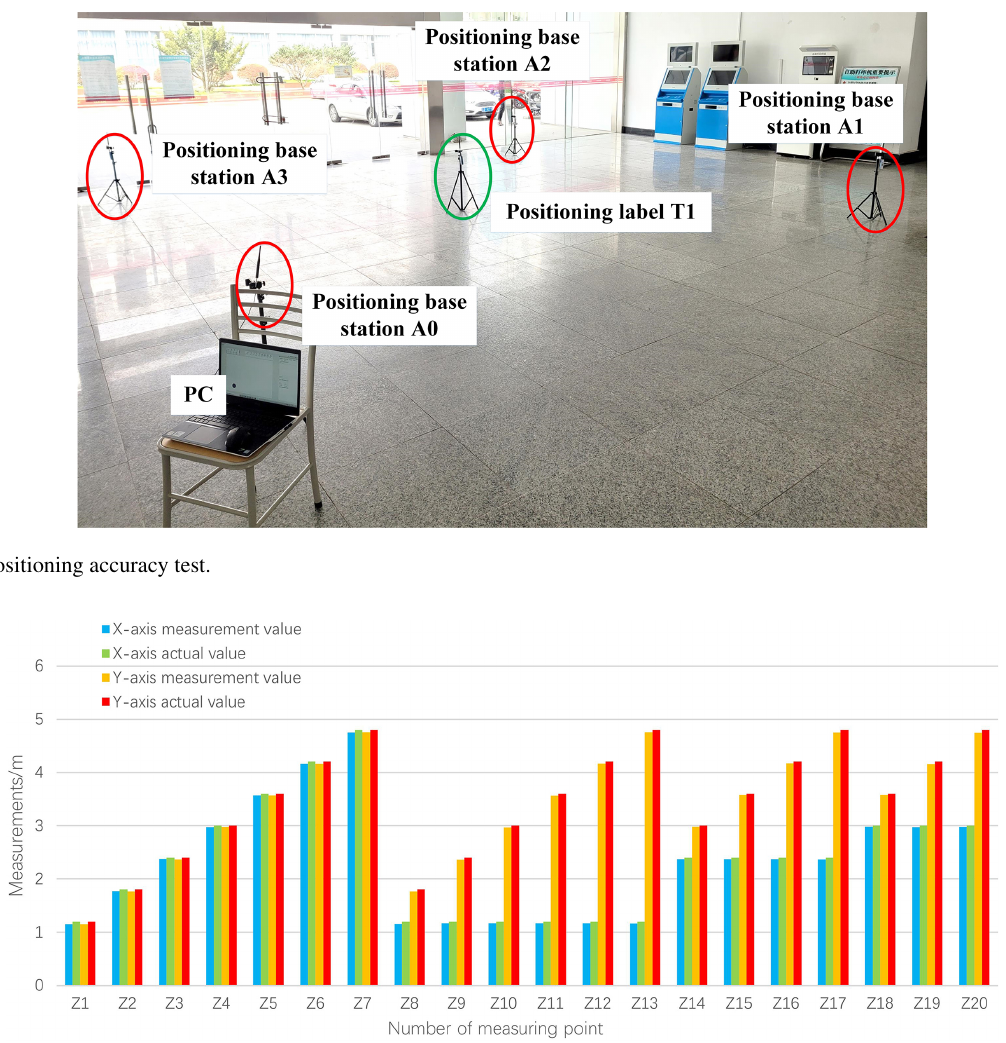
Figure 11. Actual and measured values of the fixed-point coordinate